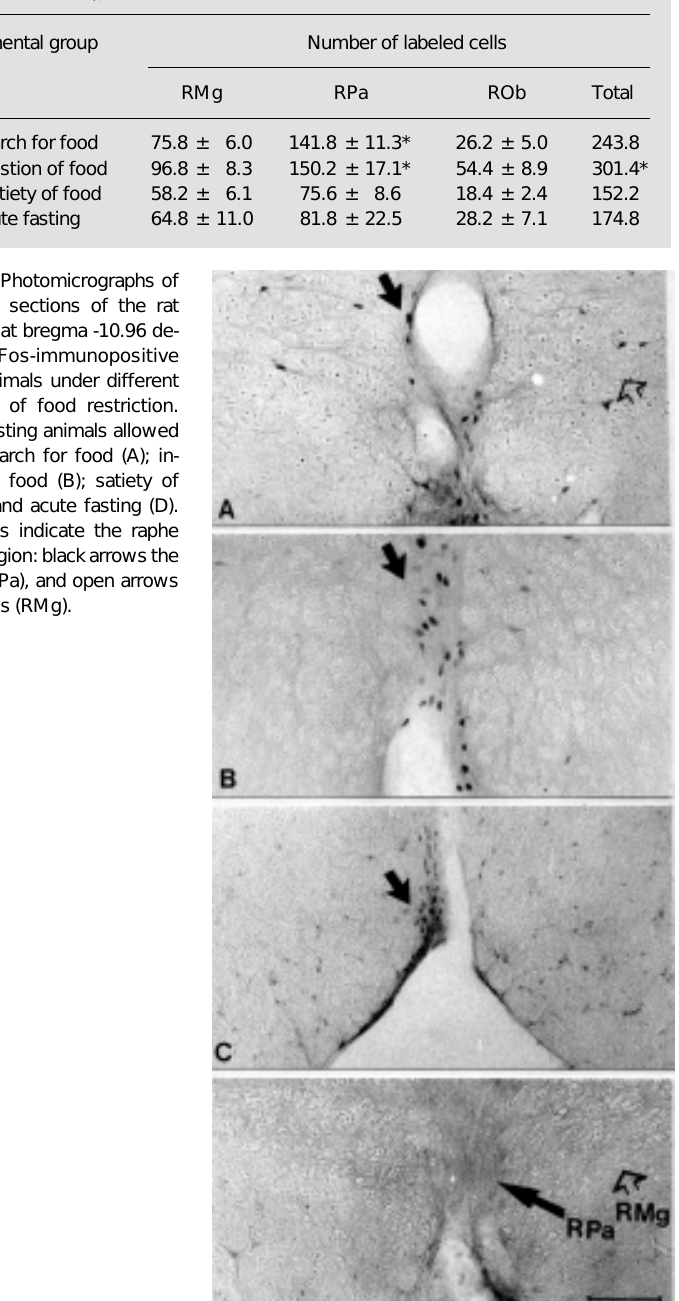
Table 1 - Number of c-Fos-immunopositive cells in the raphe nuclei, magnus (RMg), pallidus (RPa) and obscurus (ROb), in each experimental group of chronic fasting (search for food (SF), ingestion of food (IF) and satiety of food (SaF)) and of acute fasting (AF).